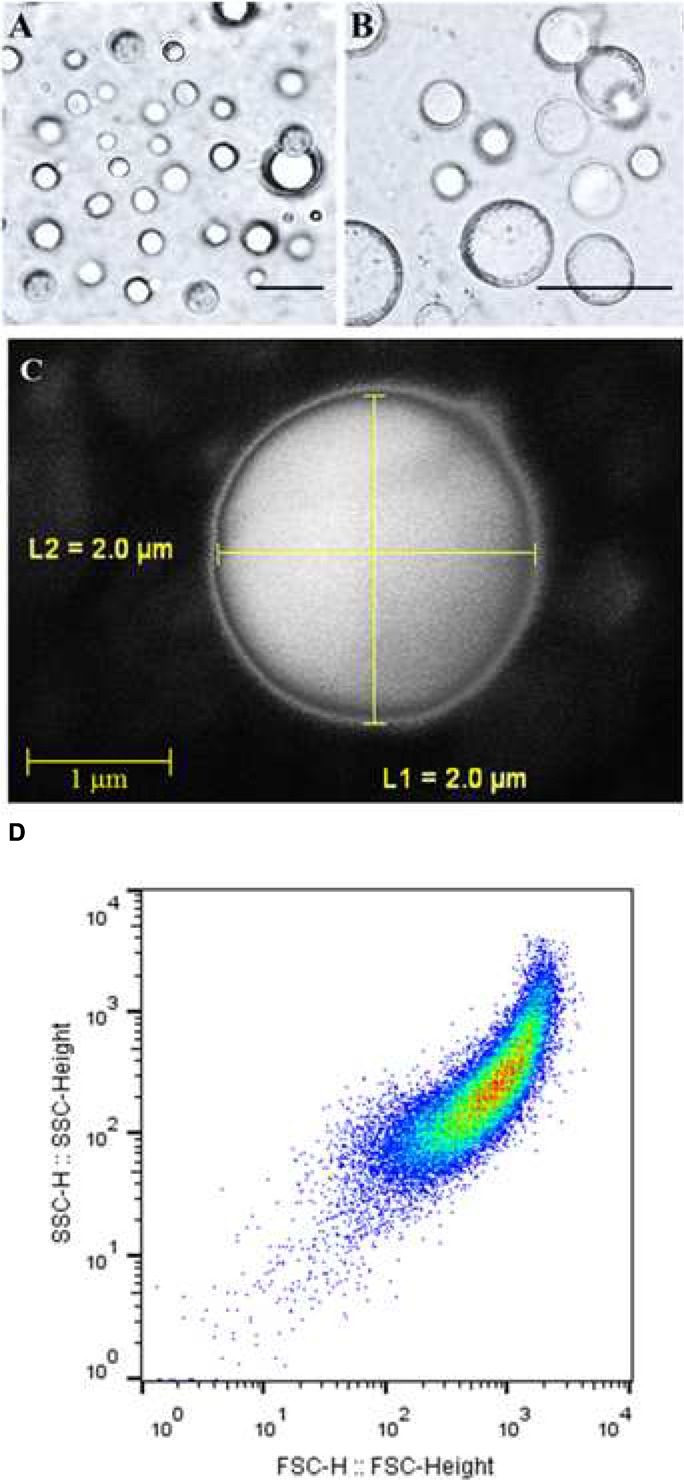
Light and electronic micrographs and Flow Cytometer analysis of the isolated LDs from seeds of date palm.
(A,B) Recovered LDs suspended in 100 mM potassium pyrophosphate at pH 7.4 were observed under a LEICA MPS60 microscope and the images viewed at a magnification of 40 and 100×, respectively. Bar represents 5 mm. (C) The LDs were examined with a scanning electron microscope (SEM). (D) The purity, size, and number of date palm LDs were evaluated by a Flow Cytometer.